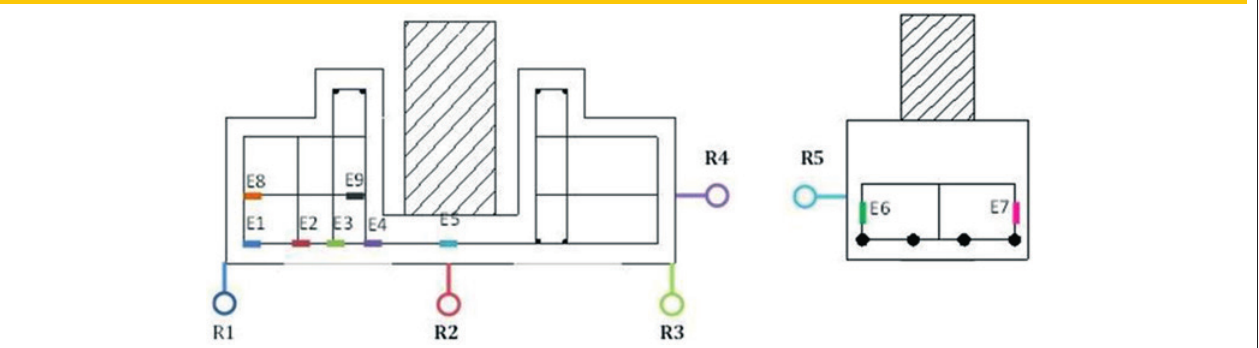
Figure 7 – Position of electrical-resistance strain gages and dial indicators in the pile caps